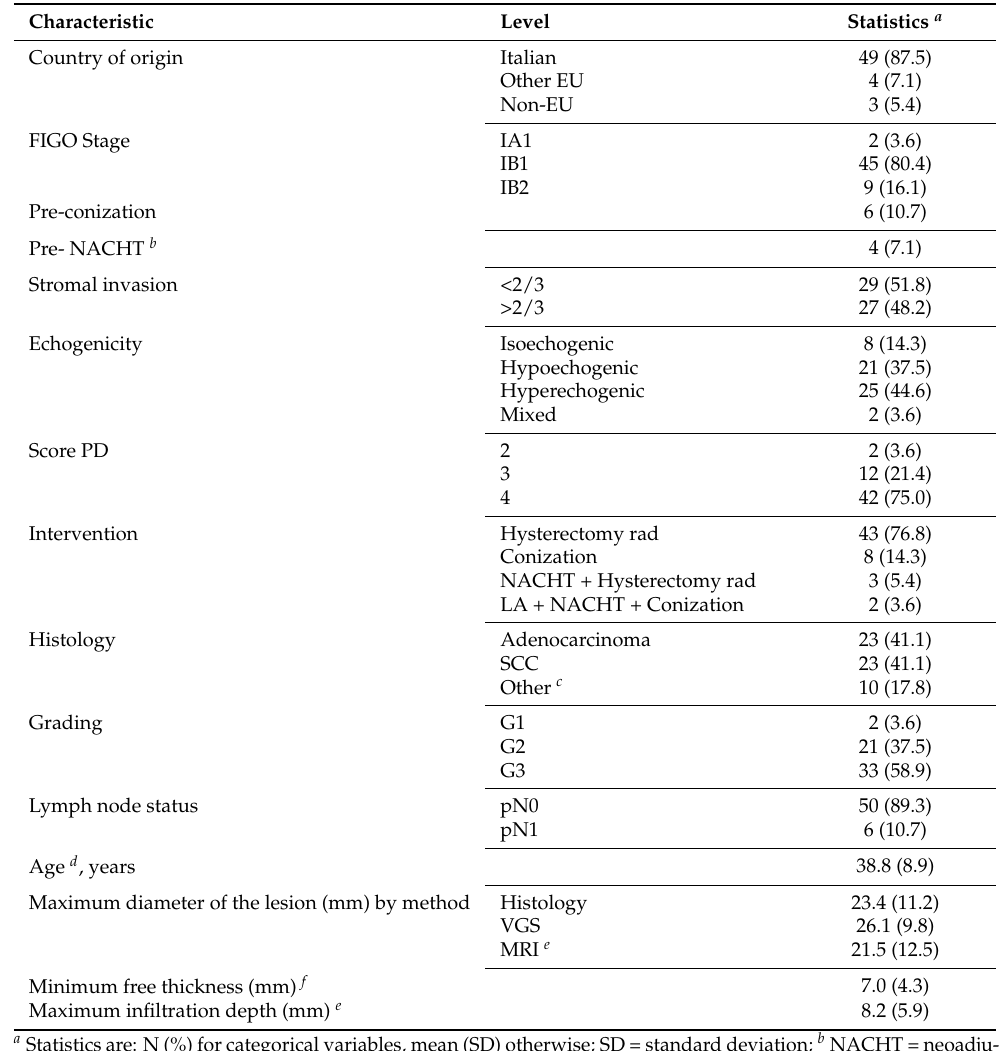
Table 1. Patients’ characteristics and treatments, N = 56.